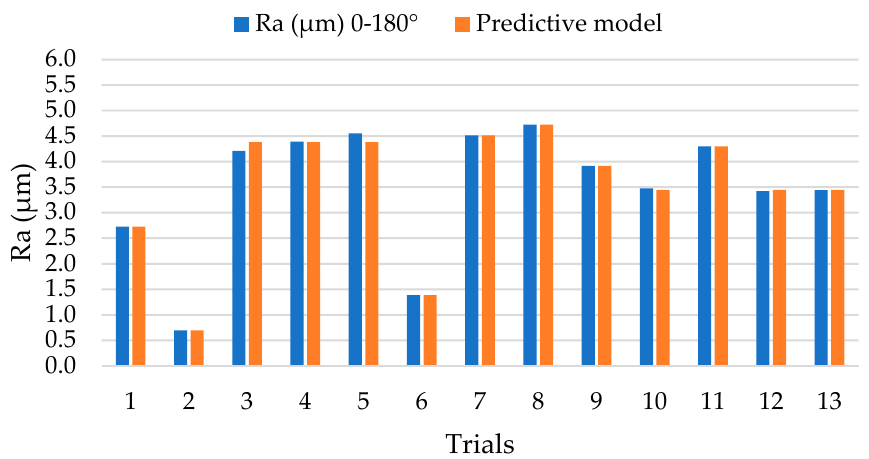
Figure 8. Comparison of Ra values between experimental tests and theoretical values of the predictive model for an orientation 0–180°.